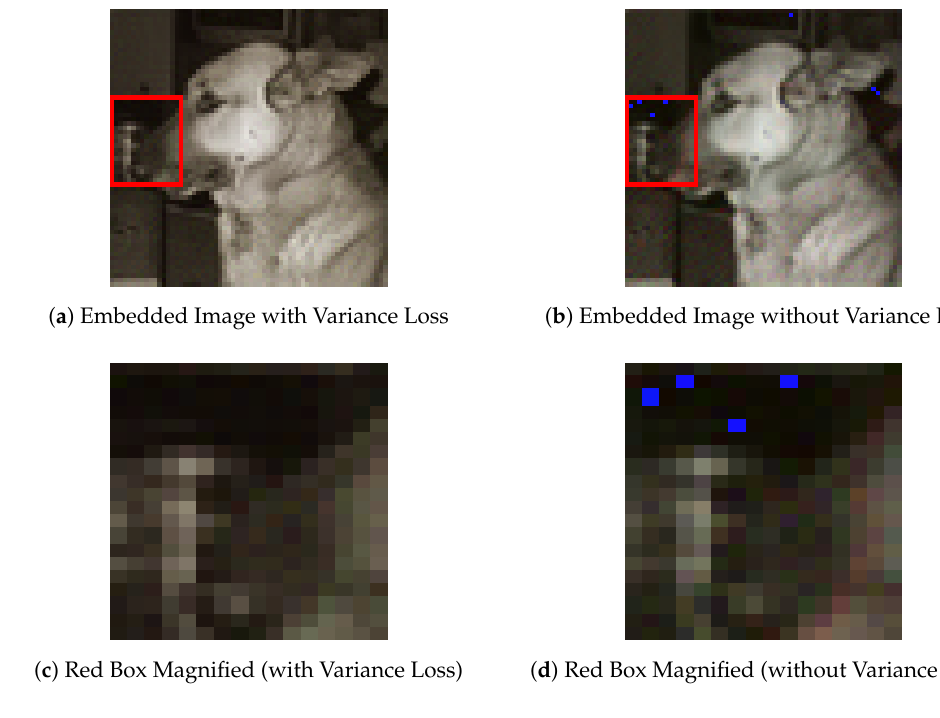
Figure 12. Variance Loss Effect on Embedding